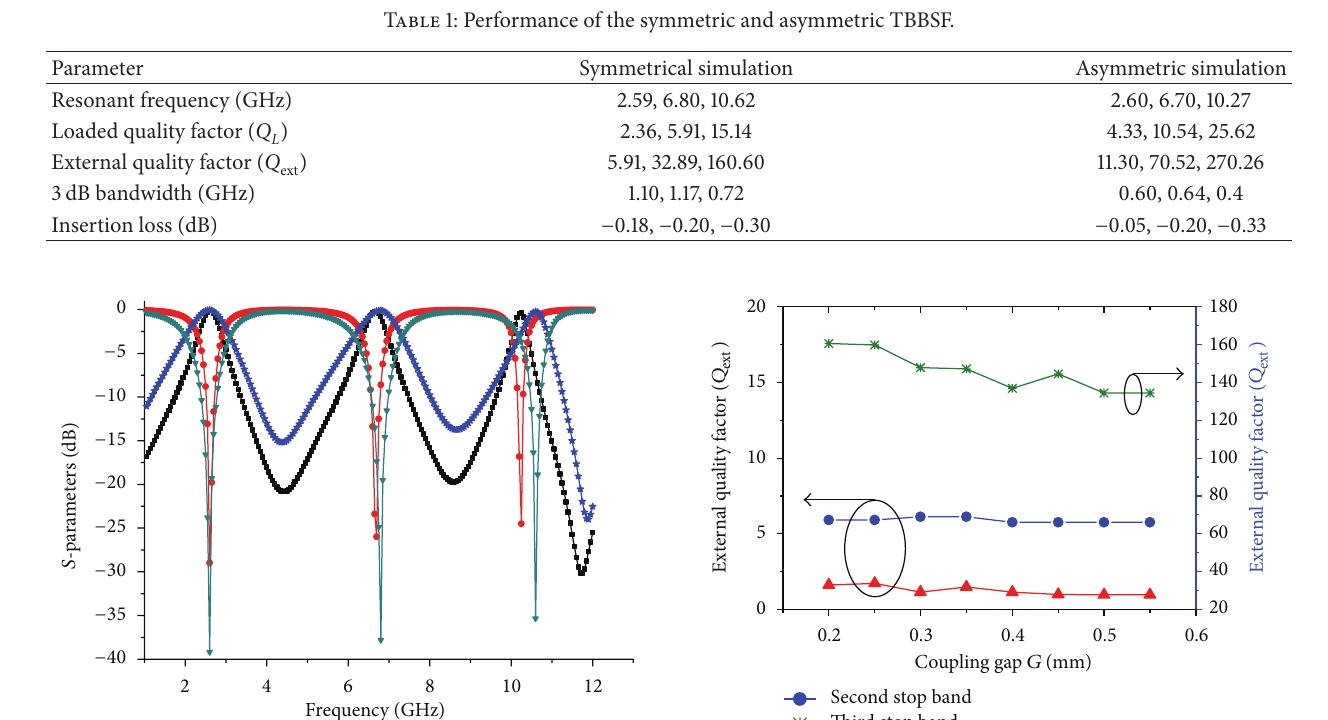
Figure 6: Behavior of 𝑄 with the corresponding folding coupling ext gap G of the symmetric TBBSF.